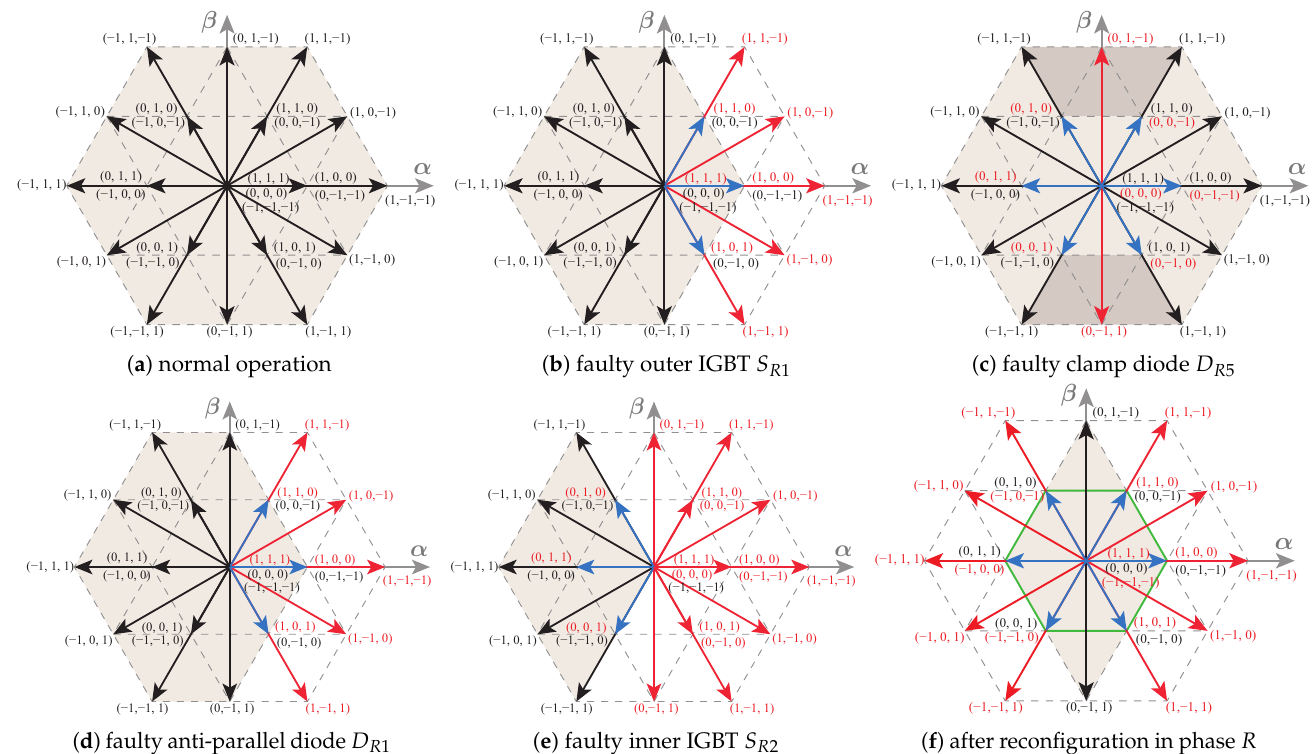
Figure 2. Available voltage vectors and modulation area in different conditions: ( a ) normal operation; ( b – e ) with OC fault in different semiconductors; ( f ) after hardware reconfiguration in phase R (switching states in red are unavailable; available modulation area is shown in gray; vectors in red are unavailable and those in blue have lost